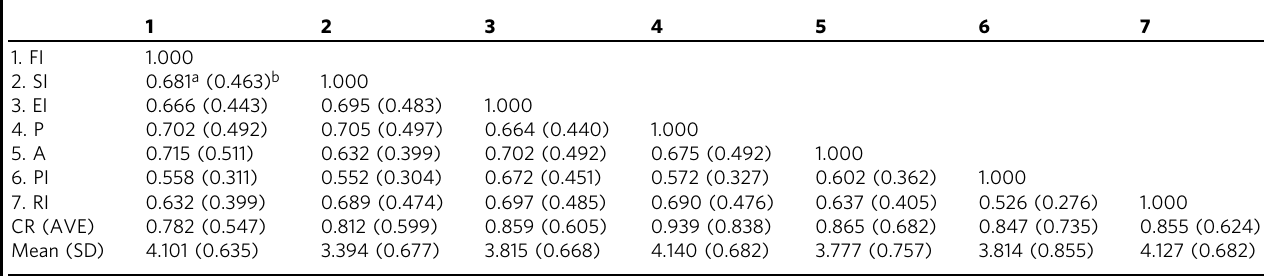
Table 3 Con fi rmatory factor analysis results and between-construct correlations.